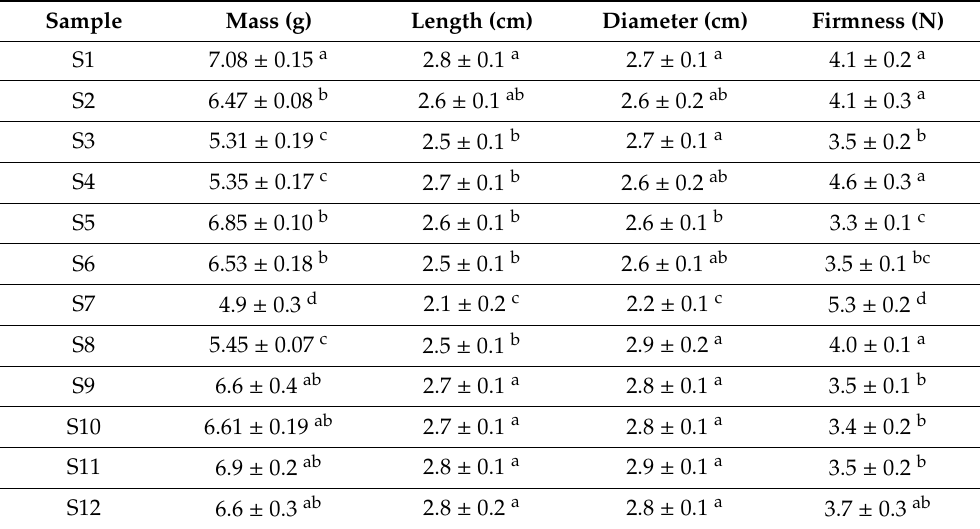
Table 2. Results obtained for the mass, length, diameter and firmness of the studied raspberry cultivars expressed as average quantities ± standard deviations ( n =